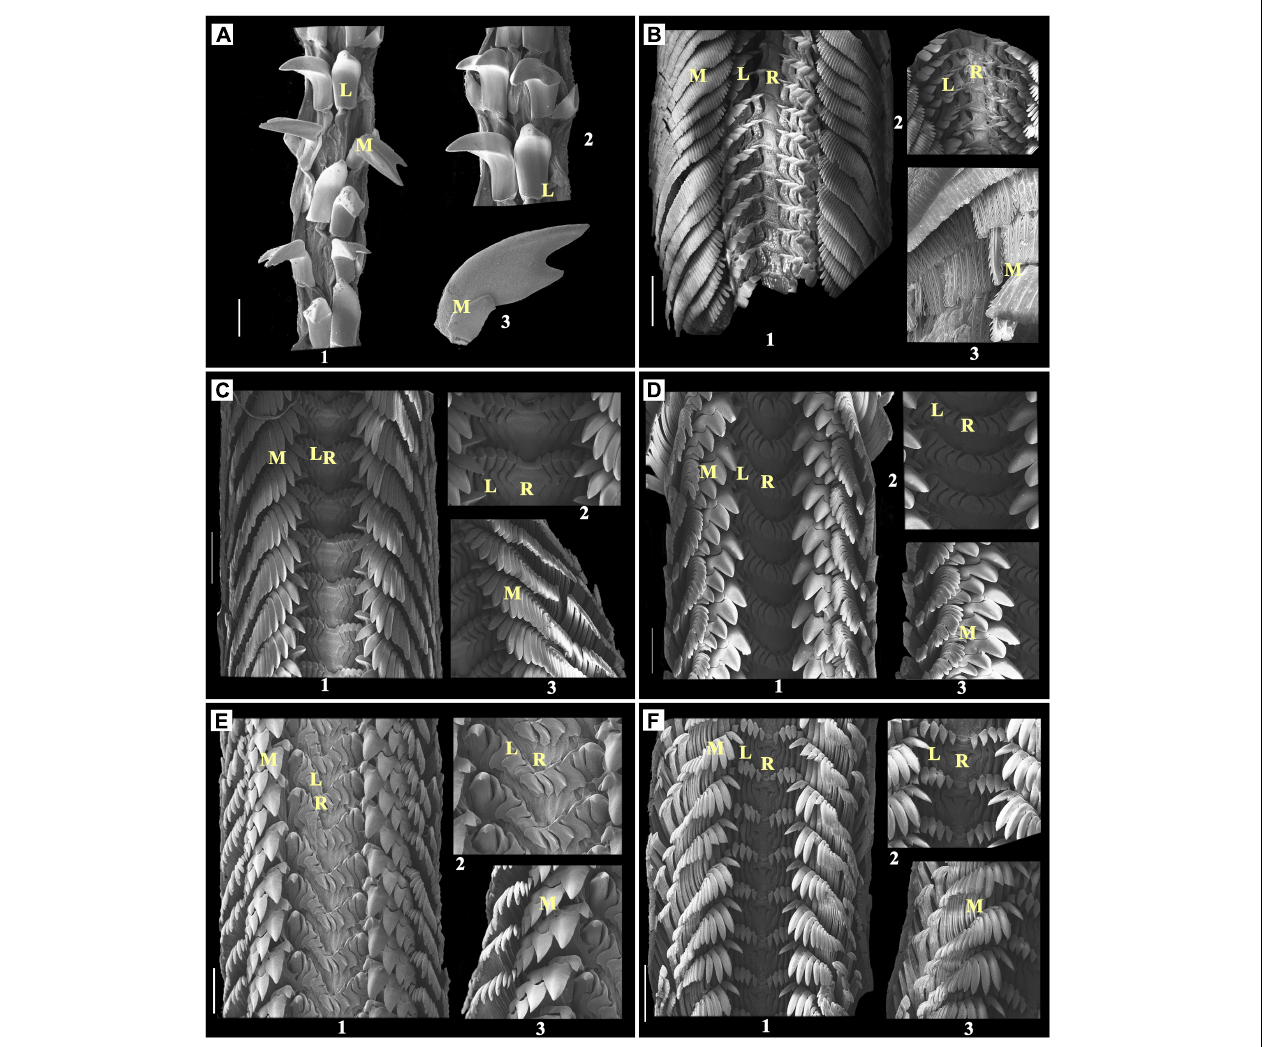
FIGURE 2 | (A) Cellana karachiensis , Scale bar:100 µ m; (B) Monodonta australis , Scale bar: 200 µ m; (C) Lunella coronata , Scale bar: 300 µ m; (D) Turbo bruneus , Scale bar: 200 µ m; (E) Turbo intercostalis , Scale bar: 300 µ m; (F) Astralium semicostatum , Scale bar: 300 µ m; 1: radula; 2 and 3: enlarged part of radula; R, rachidian teeth; L, lateral teeth; M, marginal